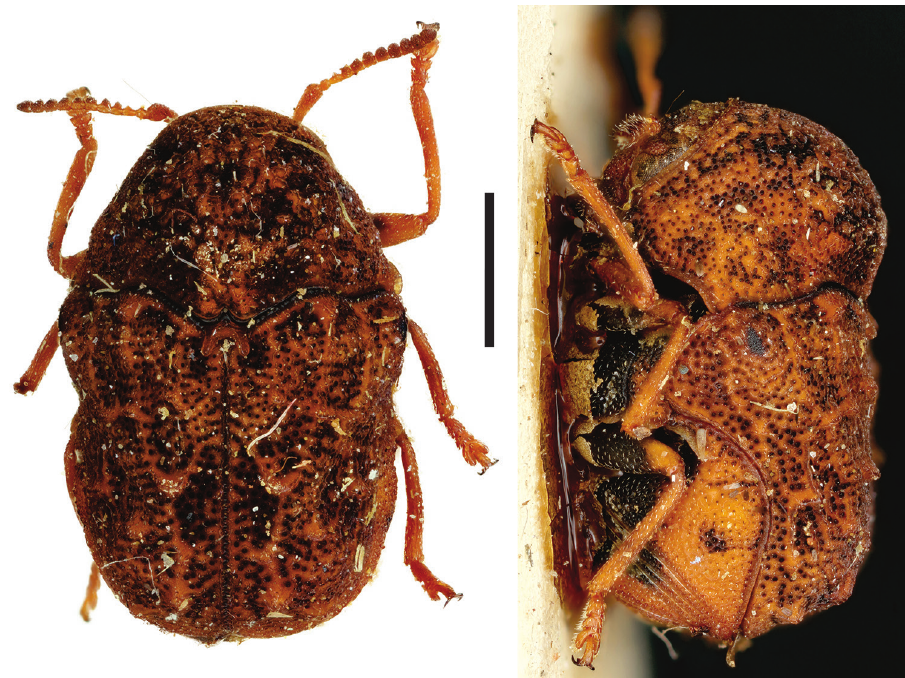
Figure 33. Pseudochlamys seminigra (Jacoby) (2) , left: habitus (dorsal view), right: habitus (lateral